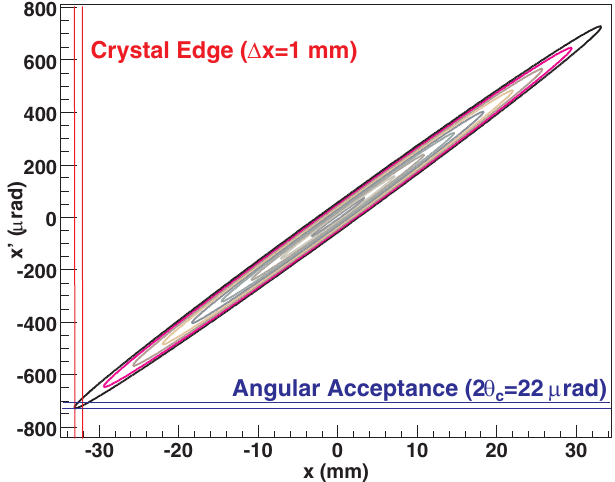
FIG. 1. (Color) Beam horizontal phase space at the RHIC crystal collimator for (cid:8) (cid:10) (cid:4) 2 m at PHENIX interaction region. Each contour is 1 (cid:6) of the beam size assuming a 15 (cid:3) mm mrad